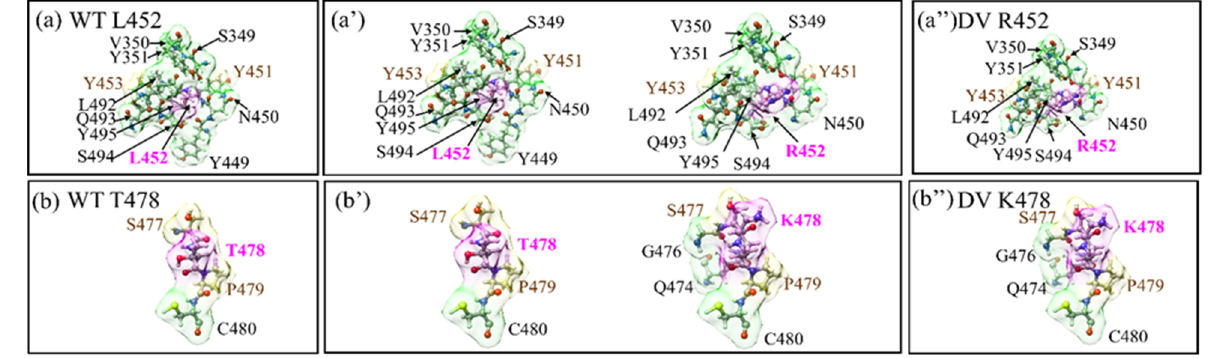
Figure 1. Comparison of changes in the shape of AABPU for the 2 DV mutations with respect to their WT sites. ( a , a’ ) are shown in the fixed scale for WT and DV for site 452 for comparison. ( a , a’’ ) are shown in the real scale. Similarly, ( b – b’’ ) shows for the site 478.